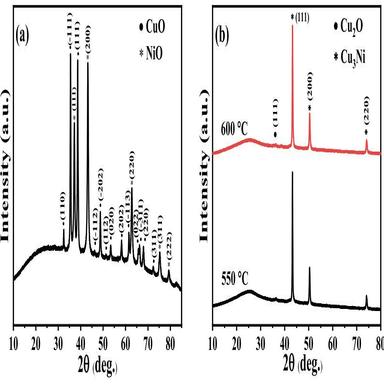
XRD patterns of the CuO-NiO/NC nanocatalysts calcined at 600 ℃ with Cu:Ni being 1:1 in starting raw materials (a), Cu3Ni/NC nanocatalysts calcined at different temperature stored in air for one year (b).